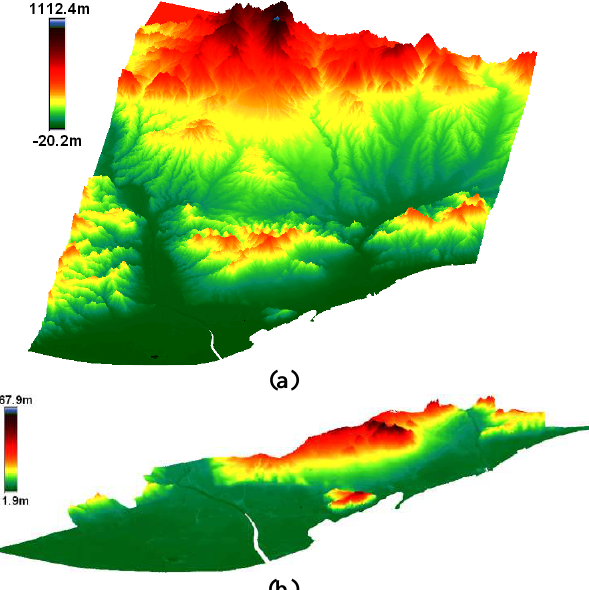
Figure 3. REFDTM of large area (a) and urban area